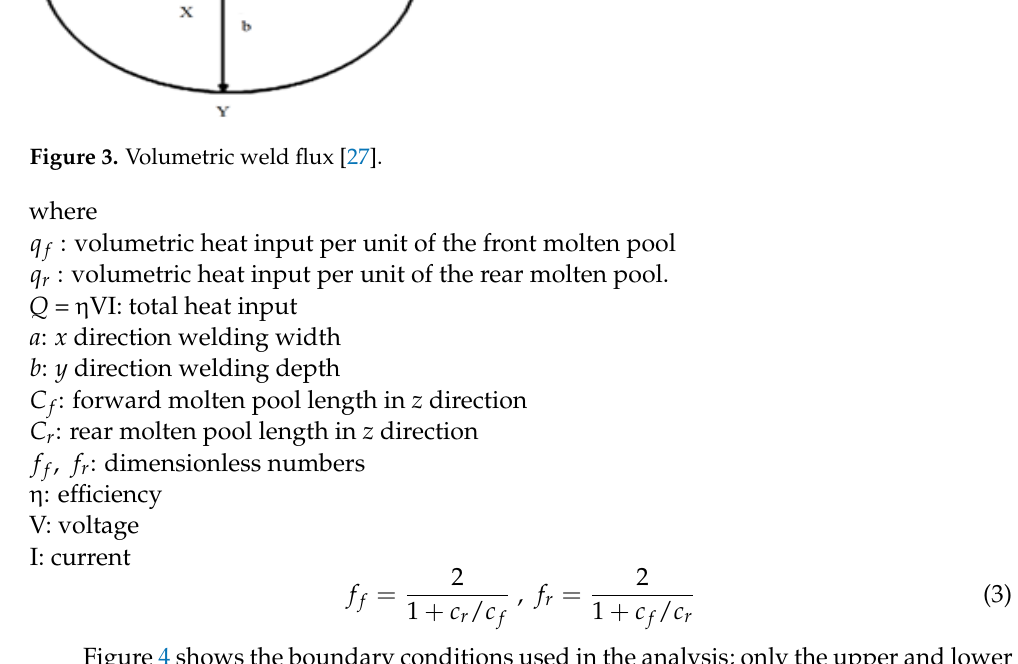
Figure 3. Volumetric weld flux [27].